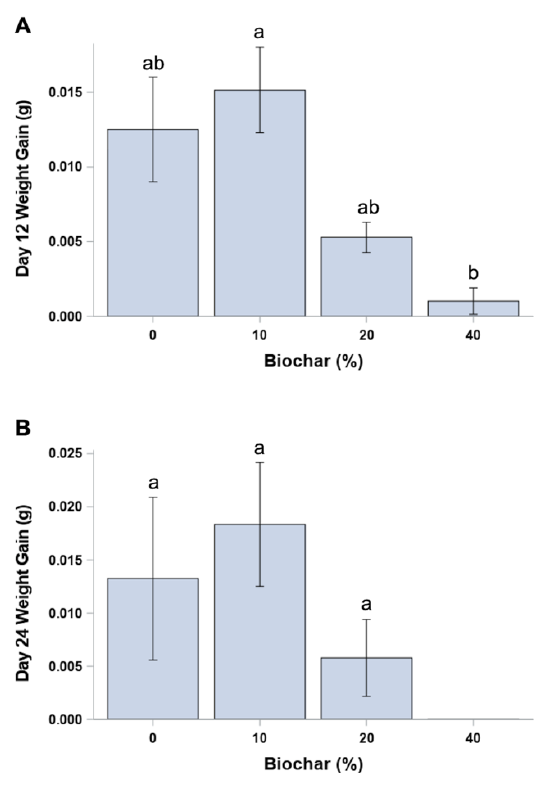
Figure 5. Mean ( ± SEM) weight gain at 12 day intervals for individual larvae measured at ( A ) day 12 and ( B ) day 24 for O. pseudotsugata reared on synthetic diet with biochar incorporated into diet at four diet:biochar (volume/volume) rates (0, 10, 20 and 40% biochar). Only 1 larva survived to day 24 and was not included in this analysis.